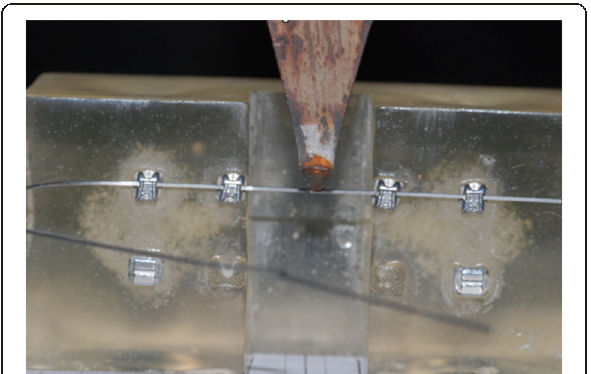
Fig. 3 Deflection, with 1 mm blade, of the portion of a real archwire using a modified three binding test (ISO 15.841